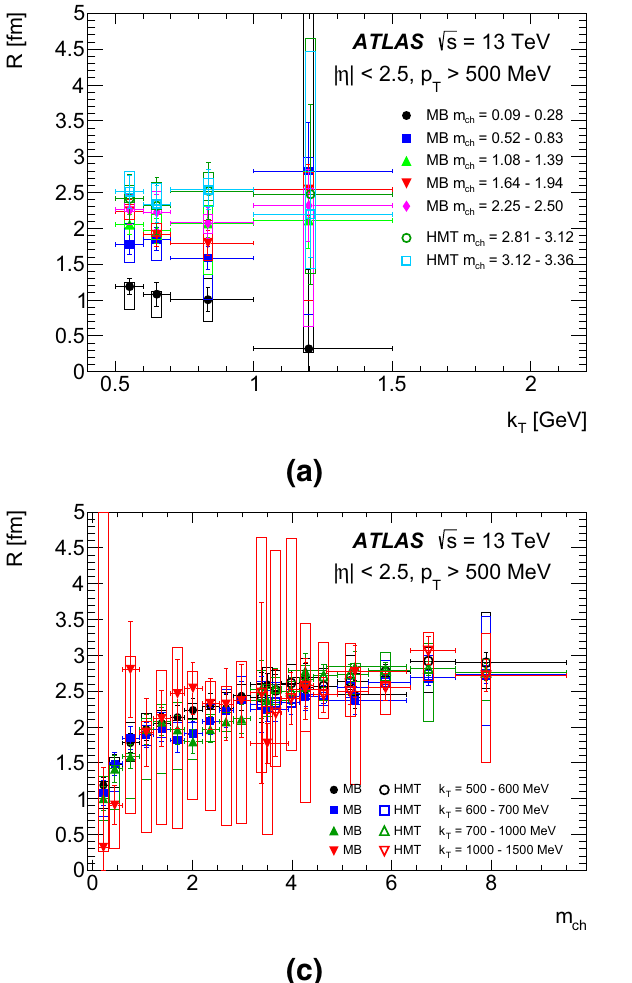
Fig. 14 The parameter R for p T > 500 MeV: a as a function of k T in selected low m ch intervals, b as a function of k T in selected high m ch intervals, and c as a function of m ch in k T intervals between 0.5 and 1.5 GeV. The error bars and boxes represent the statistical and systematic contributions,